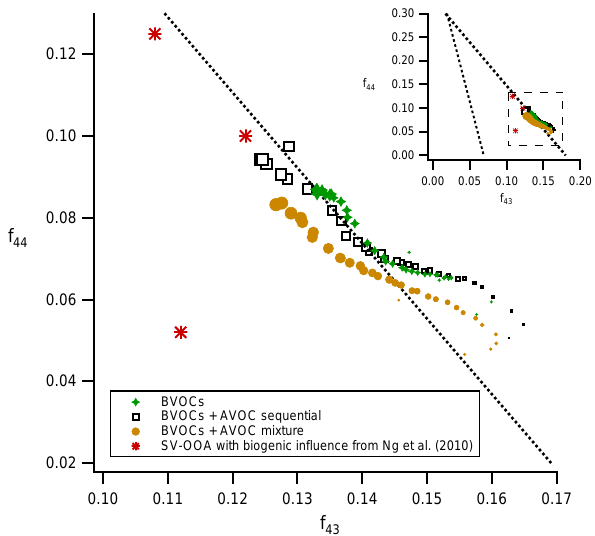
Figure 7. f 44 vs. f 43 for the SOA produced from the mixture of α -pinene and limonene (green diamonds); from the sequential addi- tion of the mixture of α -pinene and limonene followed by p -xylene- d 10 (black squares); and from the mixture of α -pinene, limonene, and p -xylene-d 10 (orange circles). The change in size of the mark- ers depicts time; smaller markers refer to the beginning of the ex- periment, and larger markers to the end. The insert shows the total triangular area (dotted lines) that represents the common values of ambient oxygenated organic aerosol components, adapted from Ng et al.